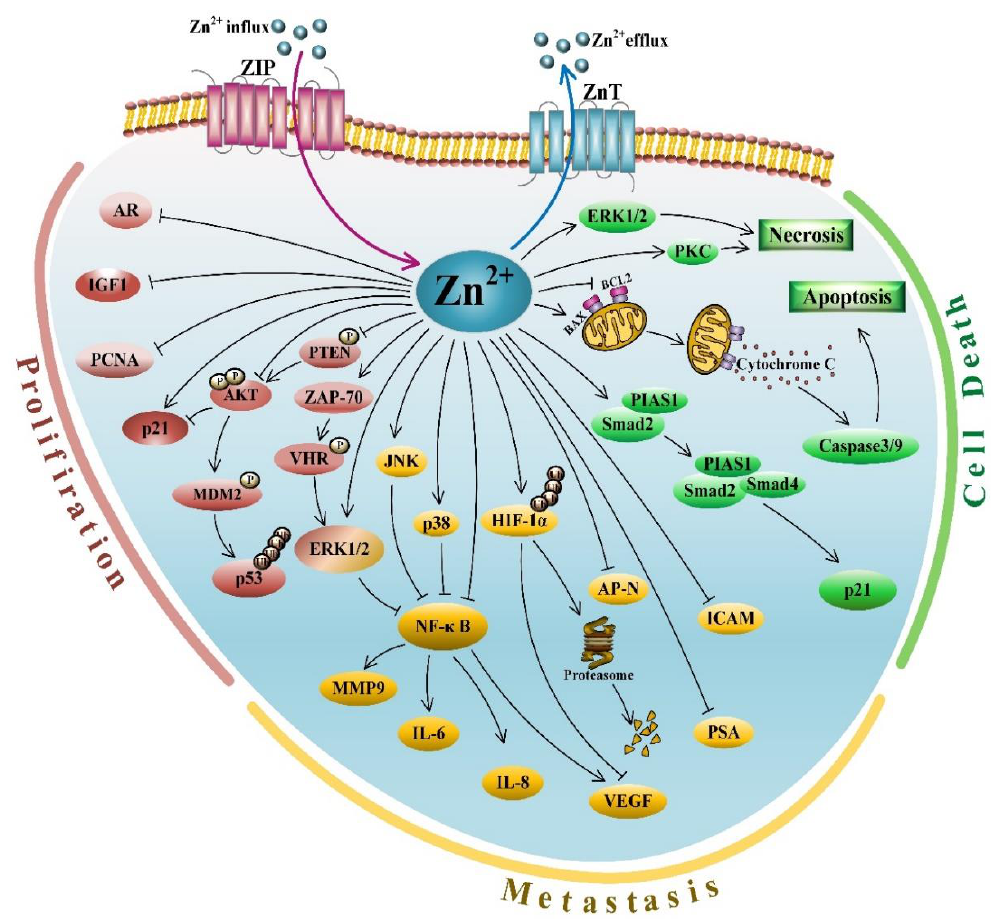
Figure 1. An overview of molecular signaling pathways mediated by zinc in PCa. Zinc is involved in various antiproliferative and proapoptotic pathways to exert its antitumor activities, including suppressing cell proliferation, inducing cell death and inhibiting metastasis. Zinc-regulated molecules involved in proliferation, metastasis and cell death, as well as zinc transporters, are grouped and differentially colored. Black T bar: inhibiting function of zinc or proteins; Blue arrow: transporting zinc from cytoplasm to extracellular fluid; Purple arrow: transporting zinc from extracellular fluid into cytoplasm; Black arrow: activating function of zinc or proteins.